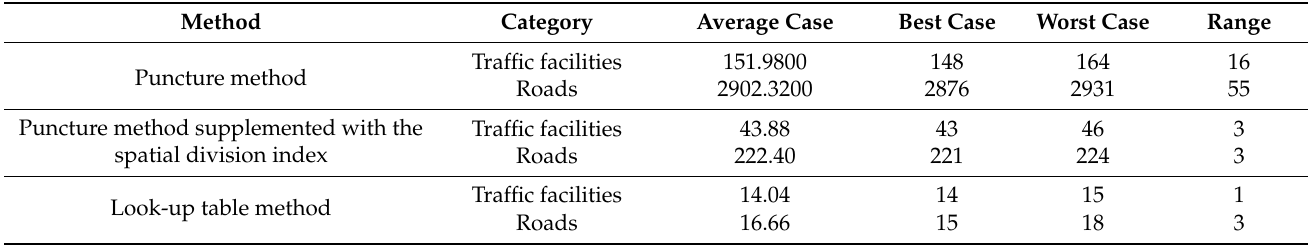
Table 6. Two groups using 100,000 samples with 50 runs.